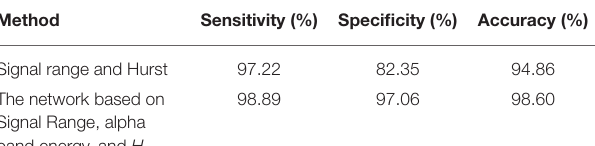
TABLE 4 | Classification performance measures.